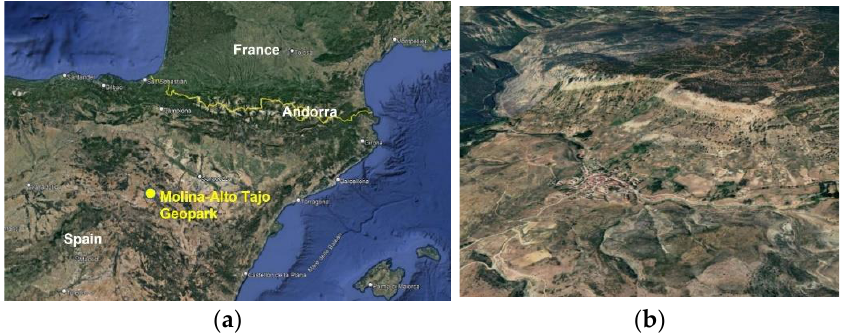
Figure 17. ( a ) The Molina Alto-Tajo Park in the Spain territory (from Google Earth Pro V 7.3.4, (14 December 2015), 40°54′21.60″N, 1°56′47.88″W, Eye alt 794.35 km, Landsat, Copernicus, SIO, NOAA, US Navy, GEBCO, Nasa, Terrametrics, Inst. Geogr. Nacional 2022, [46], modified); ( b ) the village of Peralejos de las Truchas in the reliefs of the Iberian System Mountain range, visitors ’ centre, and accommodations (from Google Earth Pro V 7.3.4, (25 August 2021), 40°35′36.56″N, 1°54′35.53″W, Eye alt 2.03 km, CNES, Airbus, Maxar Technologies 2022, [46]).